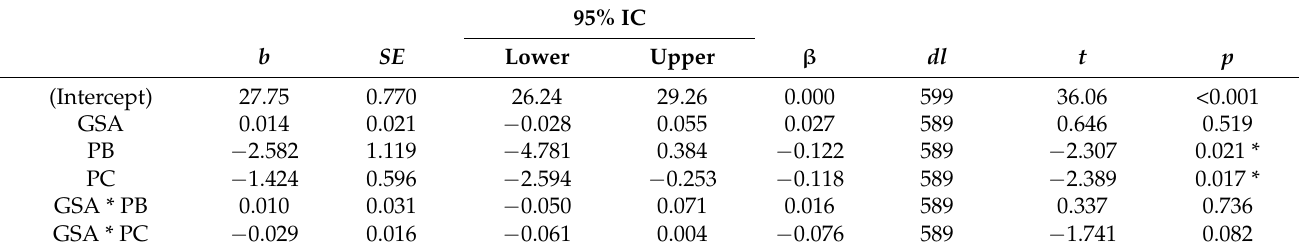
Table A1. Multiple linear regressions assessing associations between GS attendance, GS